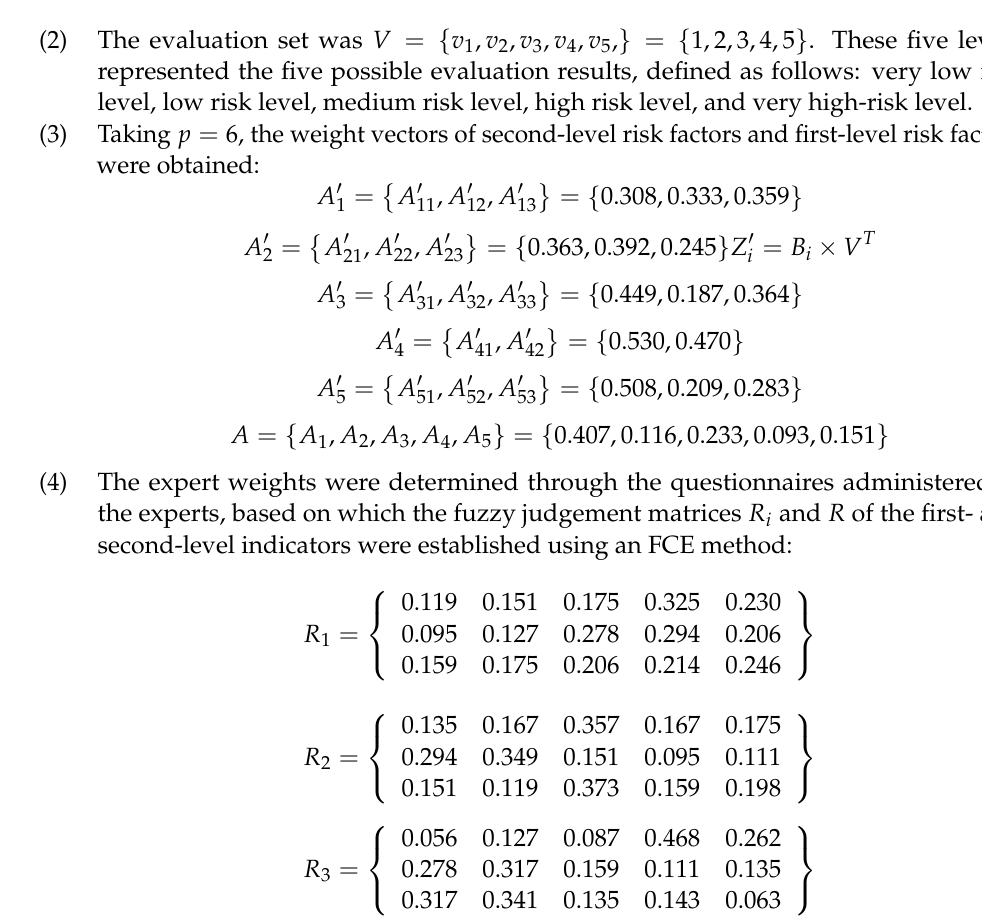
The evaluation set was V = { v 1 , v 2 , v 3 , v 4 , v 5 , } = { 1, 2, 3, 4, 5 } . These five levels represented the five possible evaluation results, defined as follows: very low risk level, low risk level, medium risk level, high risk level, and very high-risk level. Taking p = 6, the weight vectors of second-level risk factors and first-level risk factors were obtained: